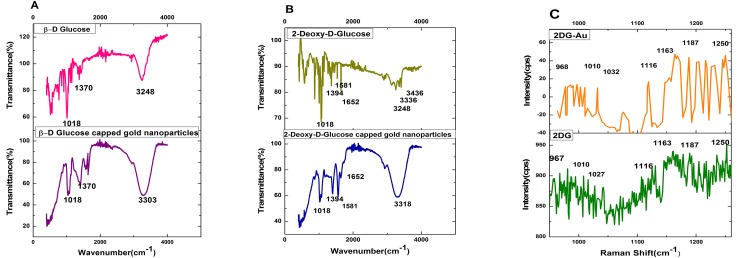
FTIR and SERS spectrum analysis.FTIR spectrum of (A) glucose and glucose-gold nanoparticles; (B) 2DG and 2DG-gold nanoparticles; C: SERS Raman spectra of 2DG-Au and Raman spectra of 2DG.